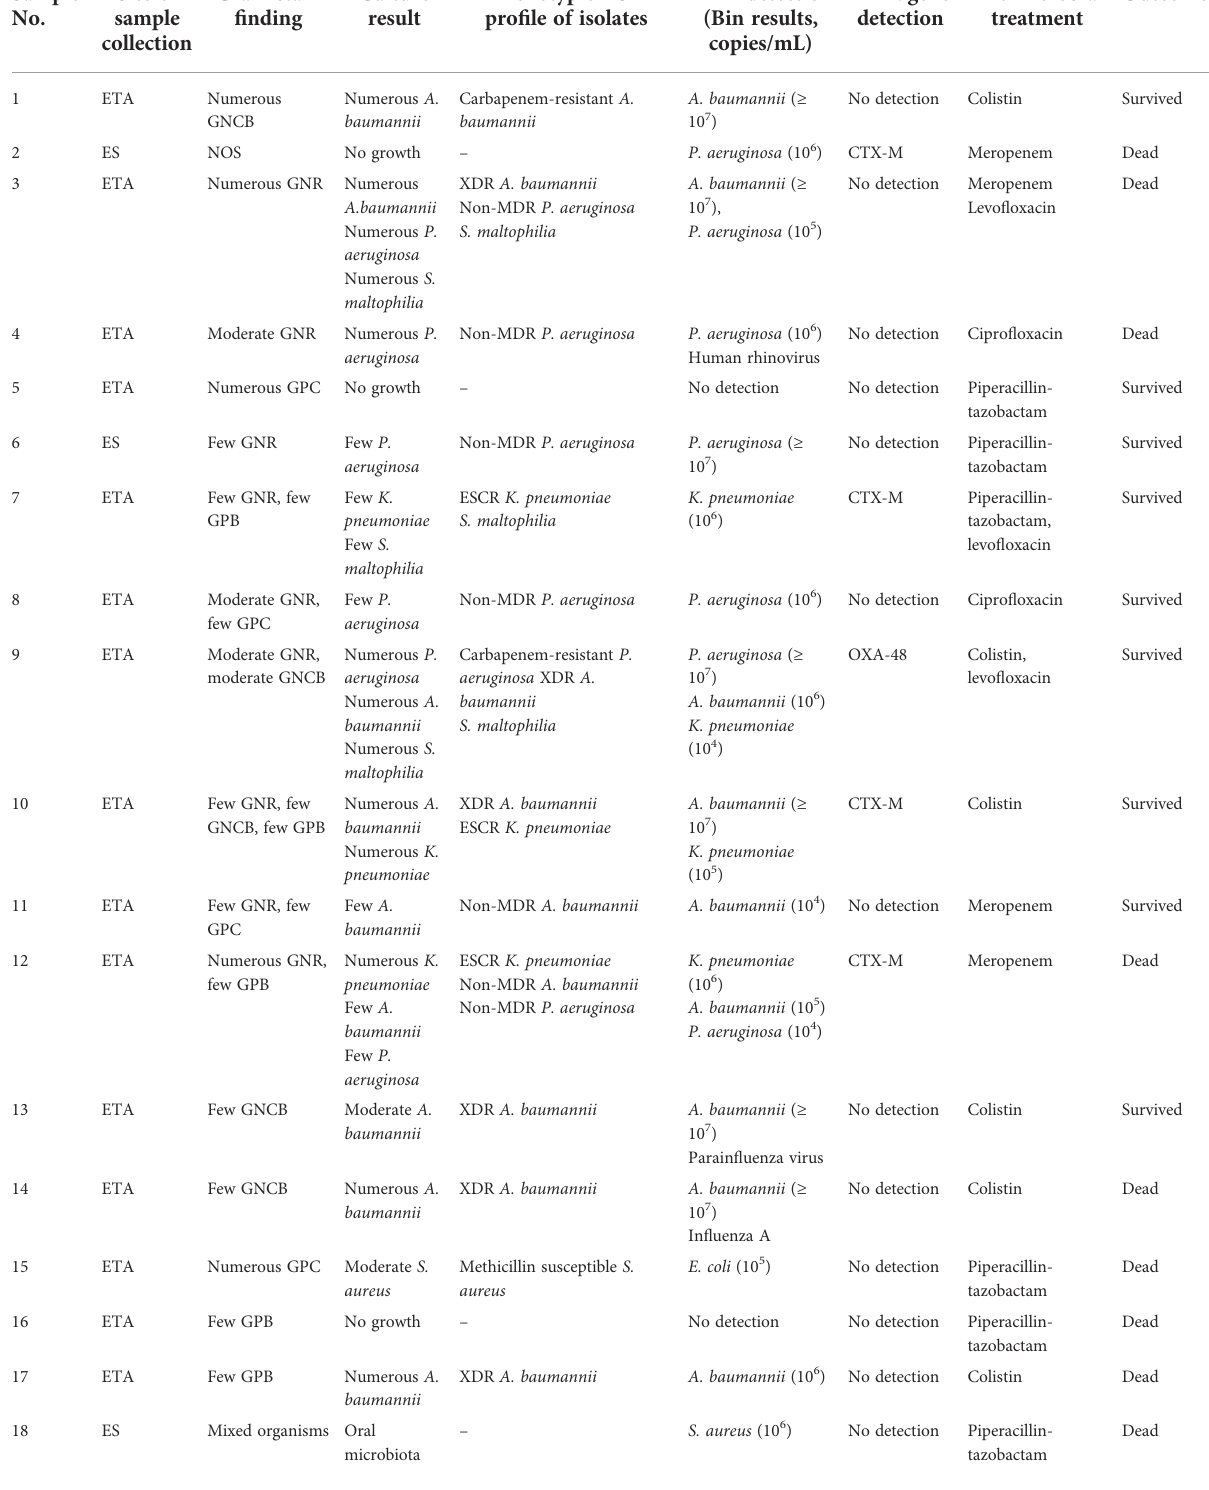
TABLE 1 Results of the standard conventional microbiological testing, antimicrobial susceptibility testing pro fi le, the BioFire FilmArray pneumonia panel plus, and antimicrobial treatment and outcomes.